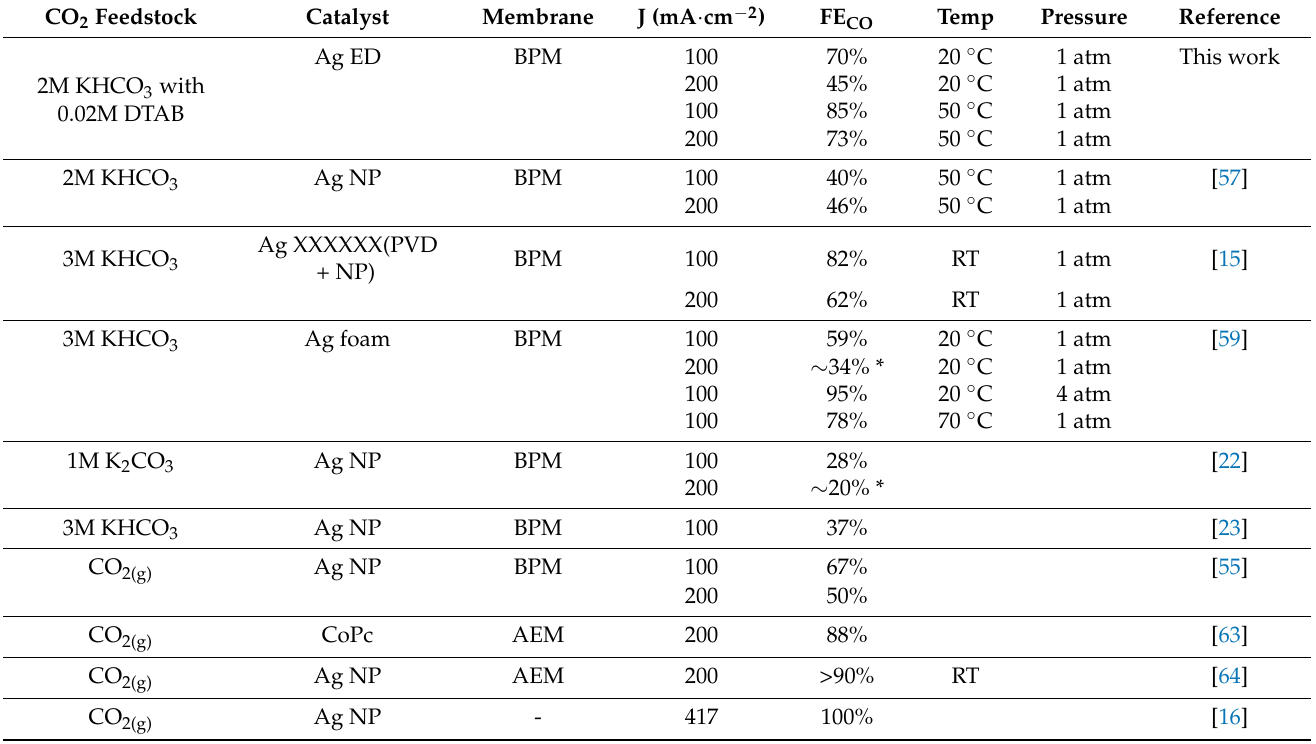
Table 1. Faradaic efficiency towards CO of CO 2 ER systems reported in the literature and their operating conditions.